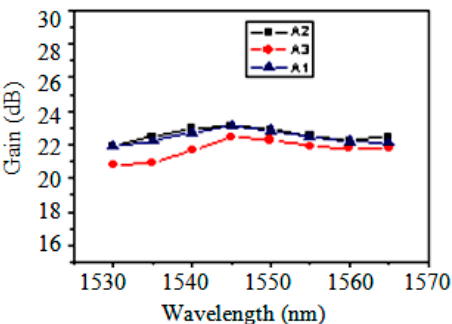
Figure 24. The optical gain curves of three EDFs (A1, A2, and A3) at C-band under 0 dBm signal power and under pump power of 400 mW.